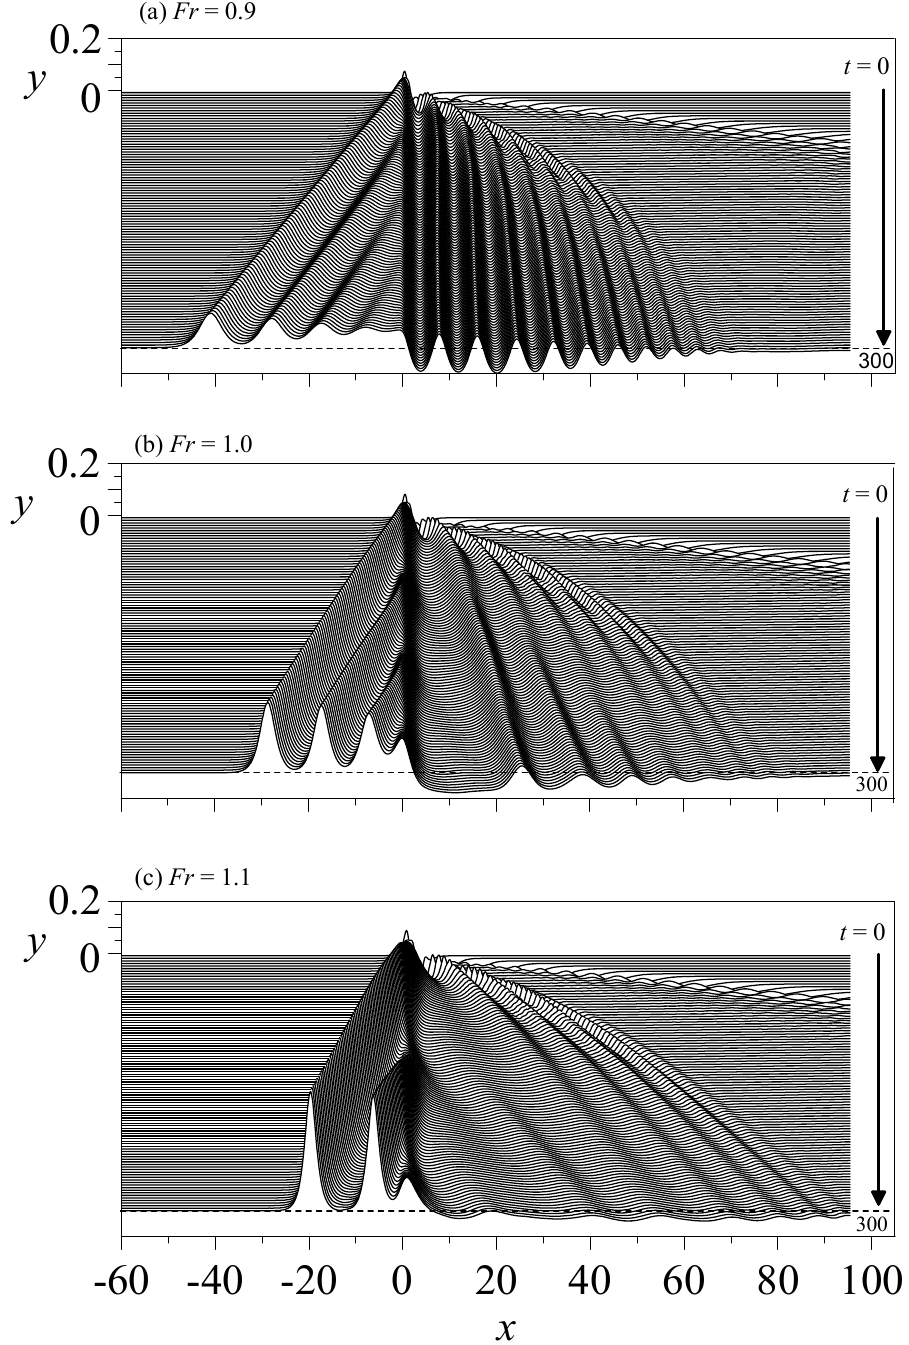
Figure 15. Time series plots of wave elevations at Re = 500 for ( a ) Fr = 0.9, ( b ) Fr = 1.0, and ( c ) Fr = 1.1.